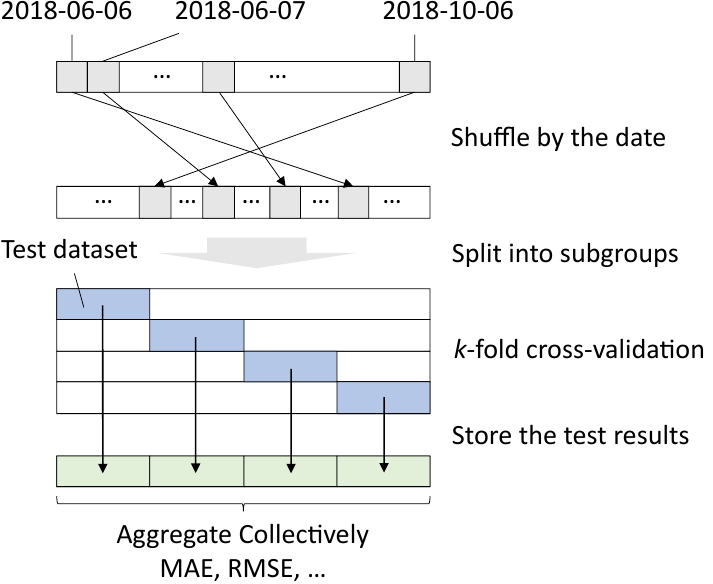
Figure 2. Configuration of the evaluation process. Dataset is shuffled by the date before the k -fold CV, and prediction results are aggregated